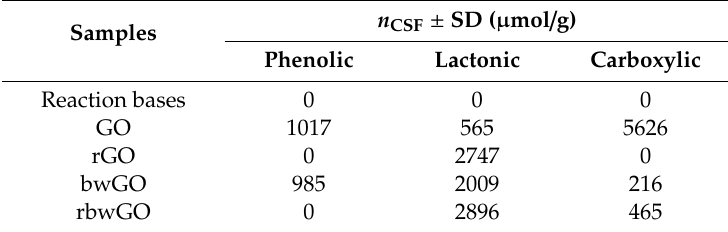
Table 1. Carbon surface functionalities ( n CSF ) of graphene oxide